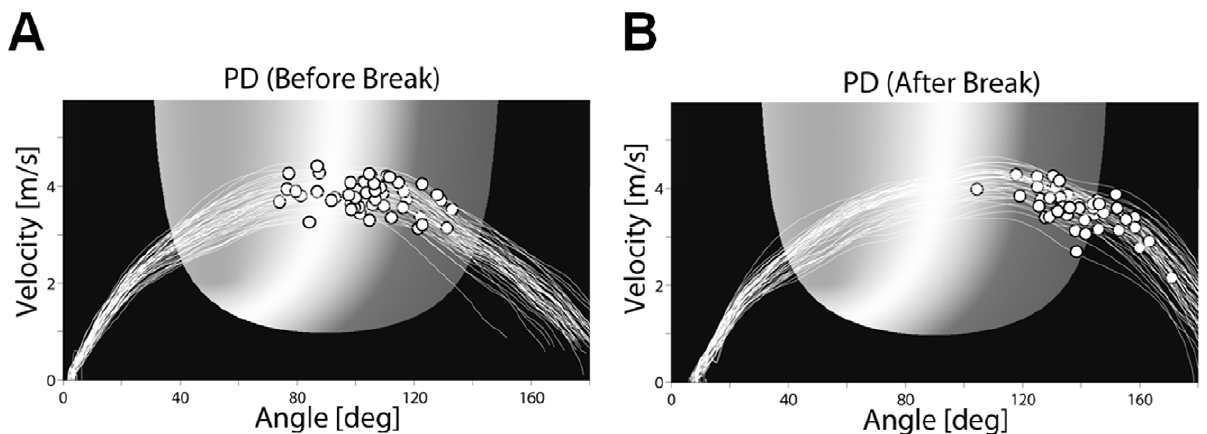
Figure 6. Sample data of release control of a PD patient. Throwing trajectories and moments of ball release of a PD patient before ( A ) and after ( B ) a break. Movement direction is from left to right. Note that although there is no time dimension in this figure, when comparing A to B, the release points in B (with higher release angles) could only be achieved by releasing later relative to A (see File S1).